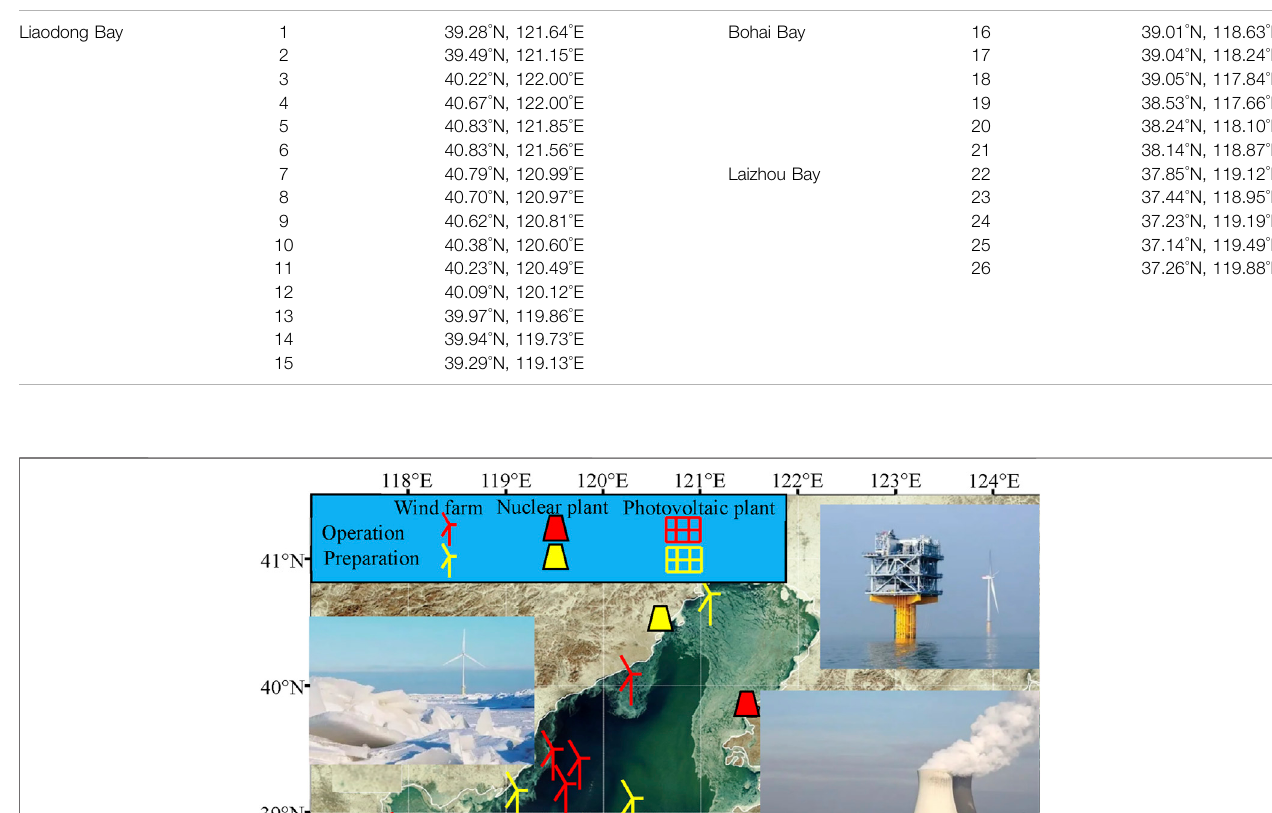
TABLE 1 | Location information of the 26 sites. Region